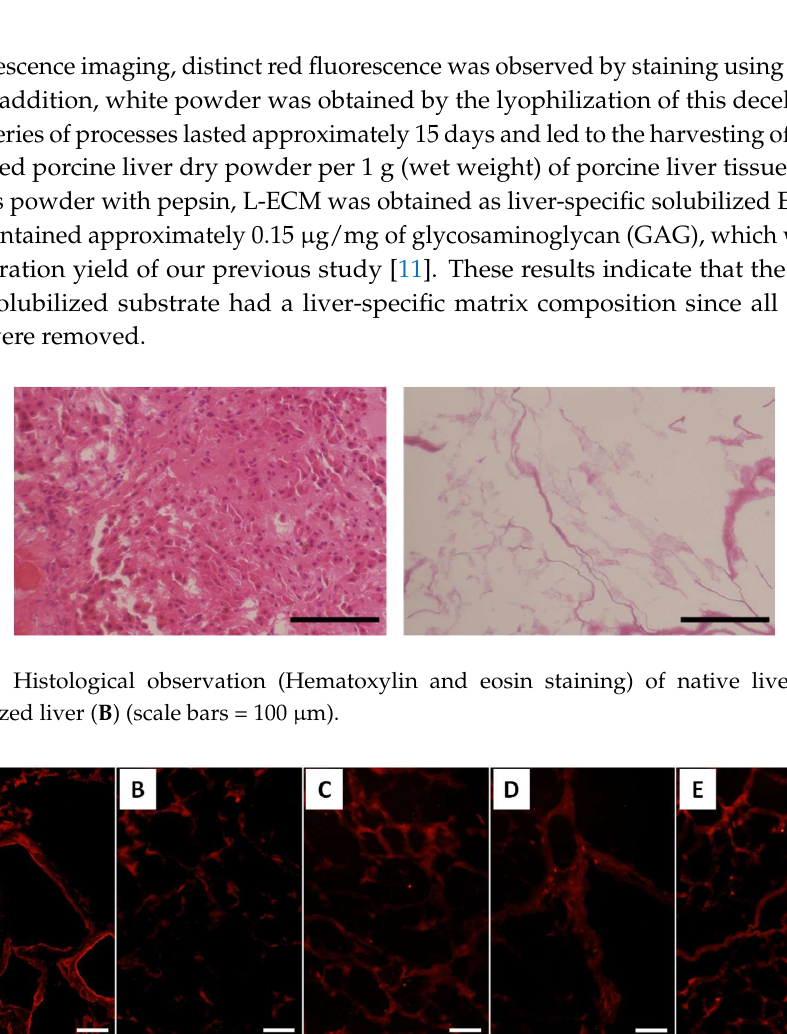
Figure 2. Immunolabeling of collagen types ( A ) I, ( B ) III, ( C ) IV, ( D ) V, and laminin ( E ), in decellularized samples with Triton solution. All images are displayed at a magnification of 20 times (scale bars = 50 μm).